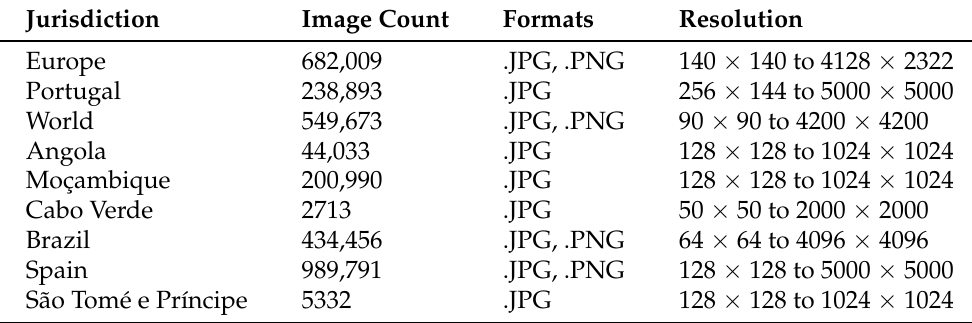
Table 1. Dataset characterization table.